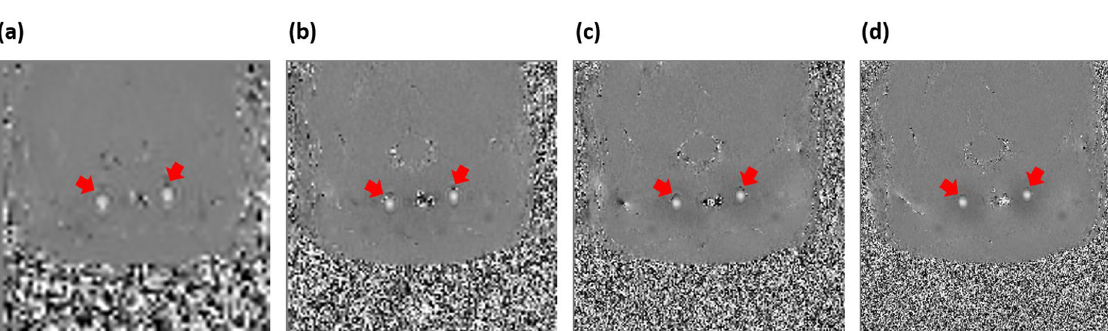
Figure 2. Influences of gated and non-gated strategies and varied values of VENC on ( a ) blood flow, ( b ) WSS, ( c ) artery area, and their corresponding CoVs (( d ), ( e ), and ( f ), respectively).